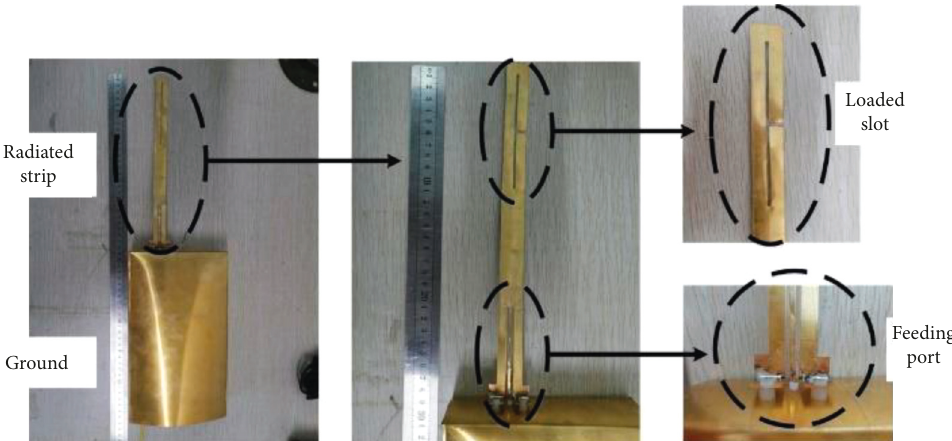
Figure 17: Validation of the simulated 1 j ) to −